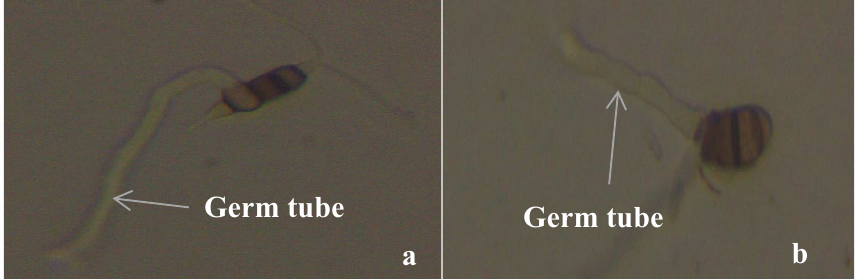
Figure 7. A germinating conidium of Pestalotiopsis species ( a ) and Curvularia species ( b